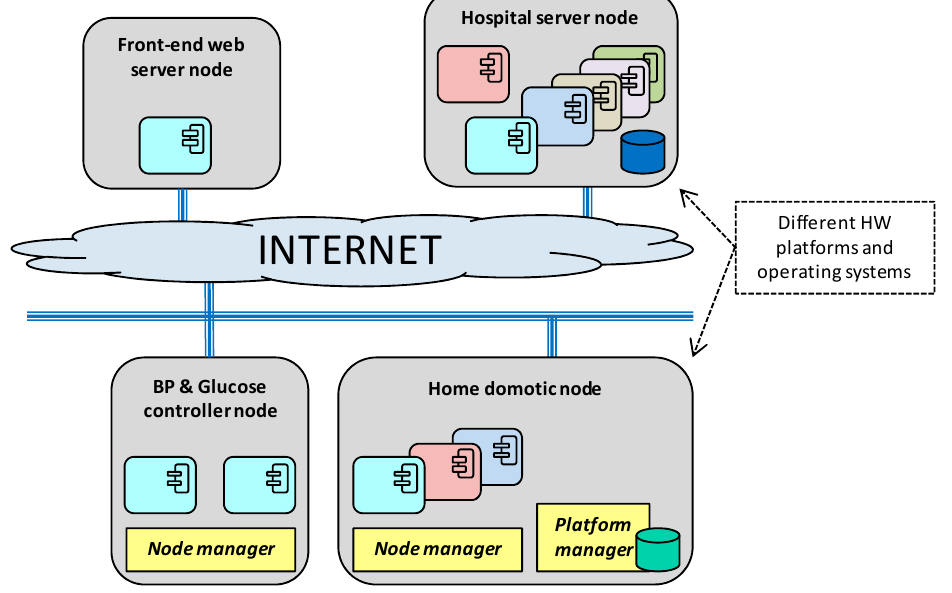
Figure 5 . Deployment of the health monitoring application on DAMP.